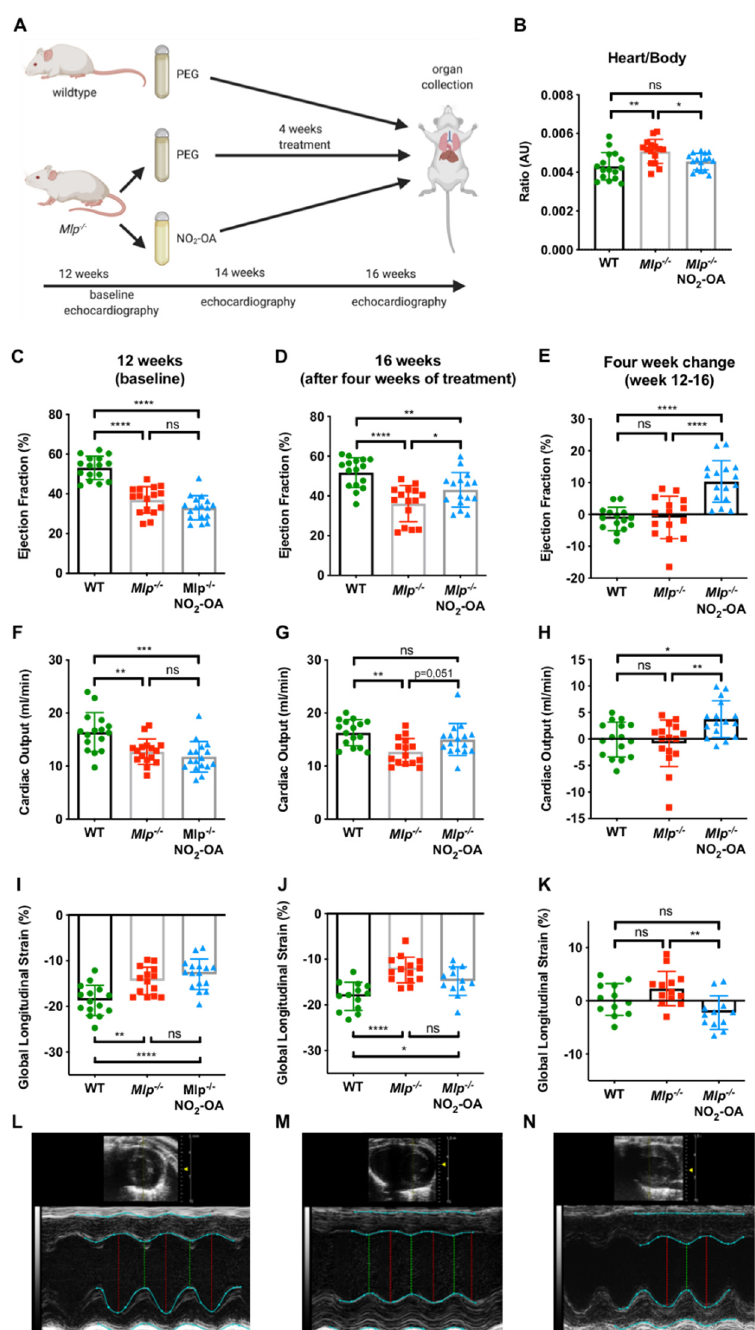
Figure 1. Effect of NO 2 -OA on left ventricular systolic function in DCM. ( A ) Experimental design of murine model treatment. ( B ) Heart-weight-to-body-weight ratio is reduced after 4 weeks of treatment with NO 2 -OA. Baseline echocardiographic assessment of ( C ) LVEF, ( F ) CO, and ( I ) GLS shows reduced baseline parameters in 12-week-old Mlp − / − animals compared to WT and ( D , G , J ) improved parameters in 16-week-old animals after 4 weeks of treatment with NO 2 -OA. Absolute change of LVEF, CO, and GLS from weeks 12–16 is shown in ( E , H , K ). Representative M-mode echocardiography tracings of ( L ) WT, ( M ) Mlp − / − , and ( N ) Mlp − / − + NO 2 -OA at 16 weeks. Data are expressed as mean ± SD, * p < 0.05, ** p < 0.01, *** p < 0.001, **** p < 0.0001, one-way ANOVA with Tukey multiple comparison test, n = 15–17 as indicated.